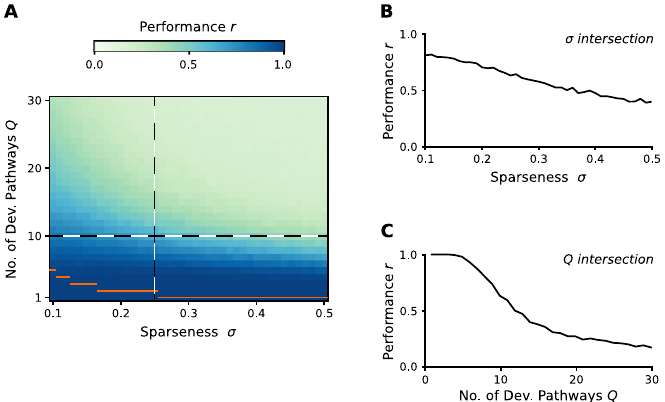
Fig 2. Performance of the analytic developmental networks. We assumed different sparseness (proportion on non- zero entries in the state vectors) values and different number of embryo-adult pairs. Embryo and desired adult vectors were generated by independently setting each vector element to high or low randomly according to the sparseness value. The performance was measured by the averaged (over 400 realizations) Pearson correlation(s) between the desired and the experienced adult state(s) for all developmental pathways (panel A). Panels B and C show a more detailed view for the two cross-sections of the parameter space (indicated by dashed lines in panel A). Orange horizontal lines show the maximum number of orthogonal state vectors for the given sparseness values. Parameters: N = 100, δ = 0.2, τ = 1, ω =